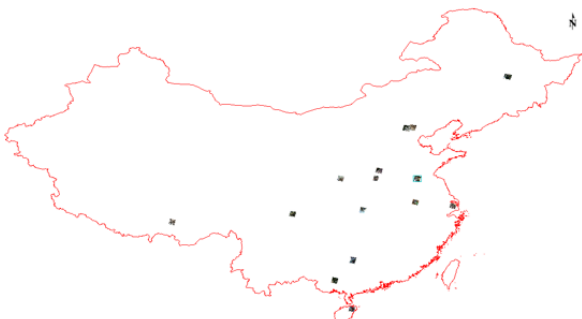
Figure 2 . Distribution of ZY1-02D experimental images